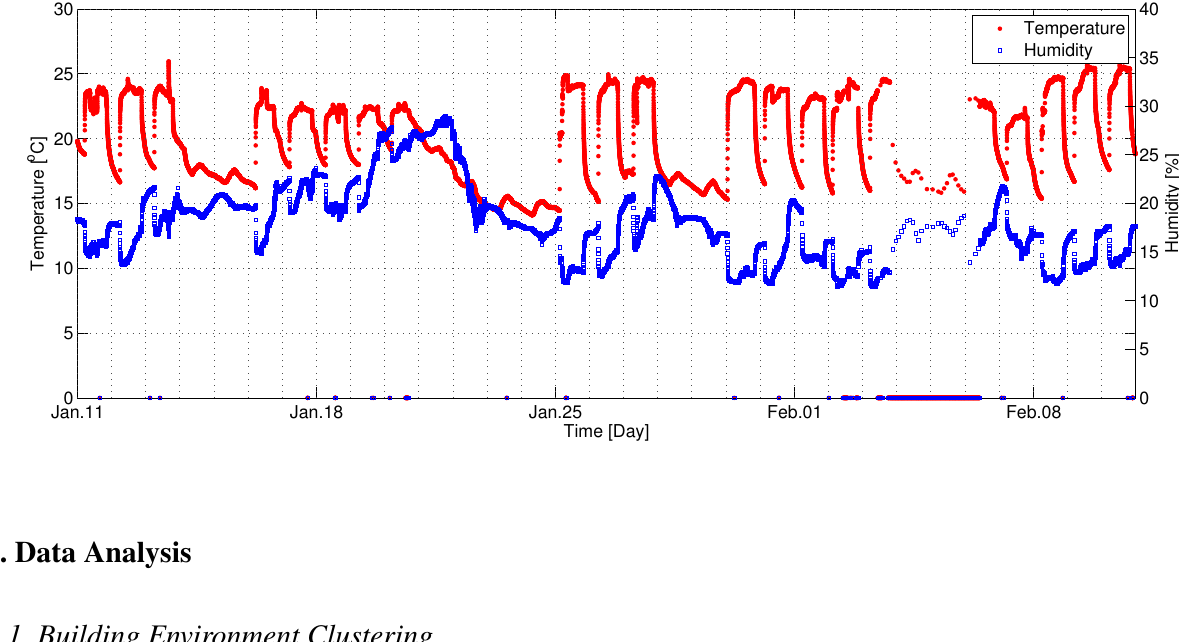
Figure 3. Temperature (red) and humidity (blue) data collected from a wireless sensor node from 11 January 2012 to 10 February